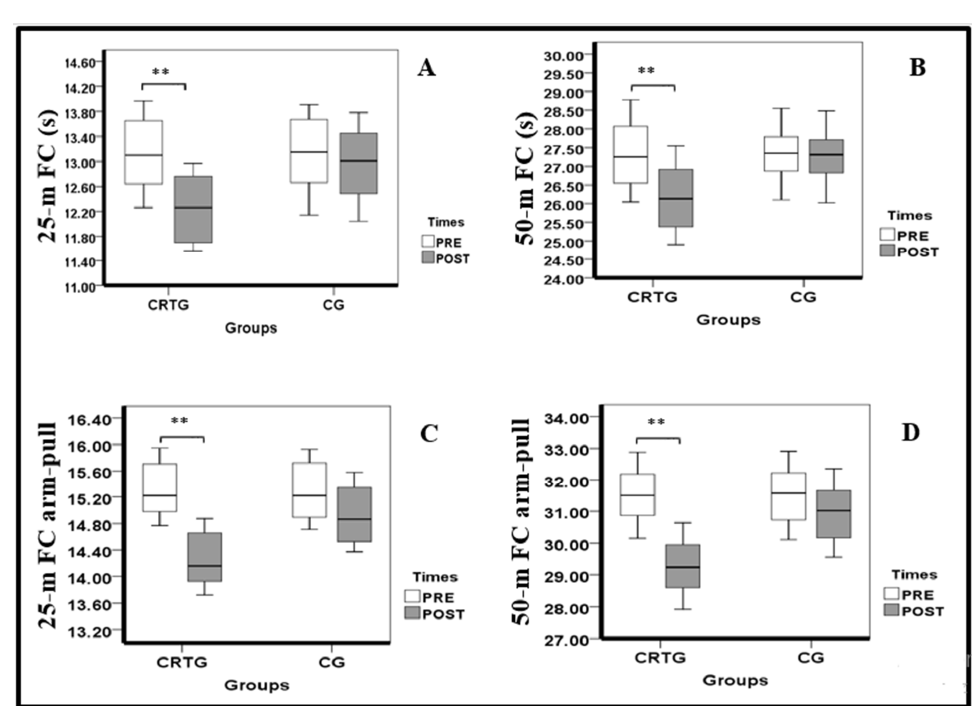
Figure 3. Box plots displaying the 25th and 75th percentiles, medians and whiskers extending from the minimal to maximal for the ( A ) 25-m FC, ( B ) 50-m FC, ( C ) 25-m FC arm pull and ( D ) 50-m FC arm pull in both groups (CRTG and CG) after 9 weeks of training (** p < 0.01). FC: front crawl. Int. J. Environ. Res. Public Health 2021 , 18 , x FOR PEER REVIEW